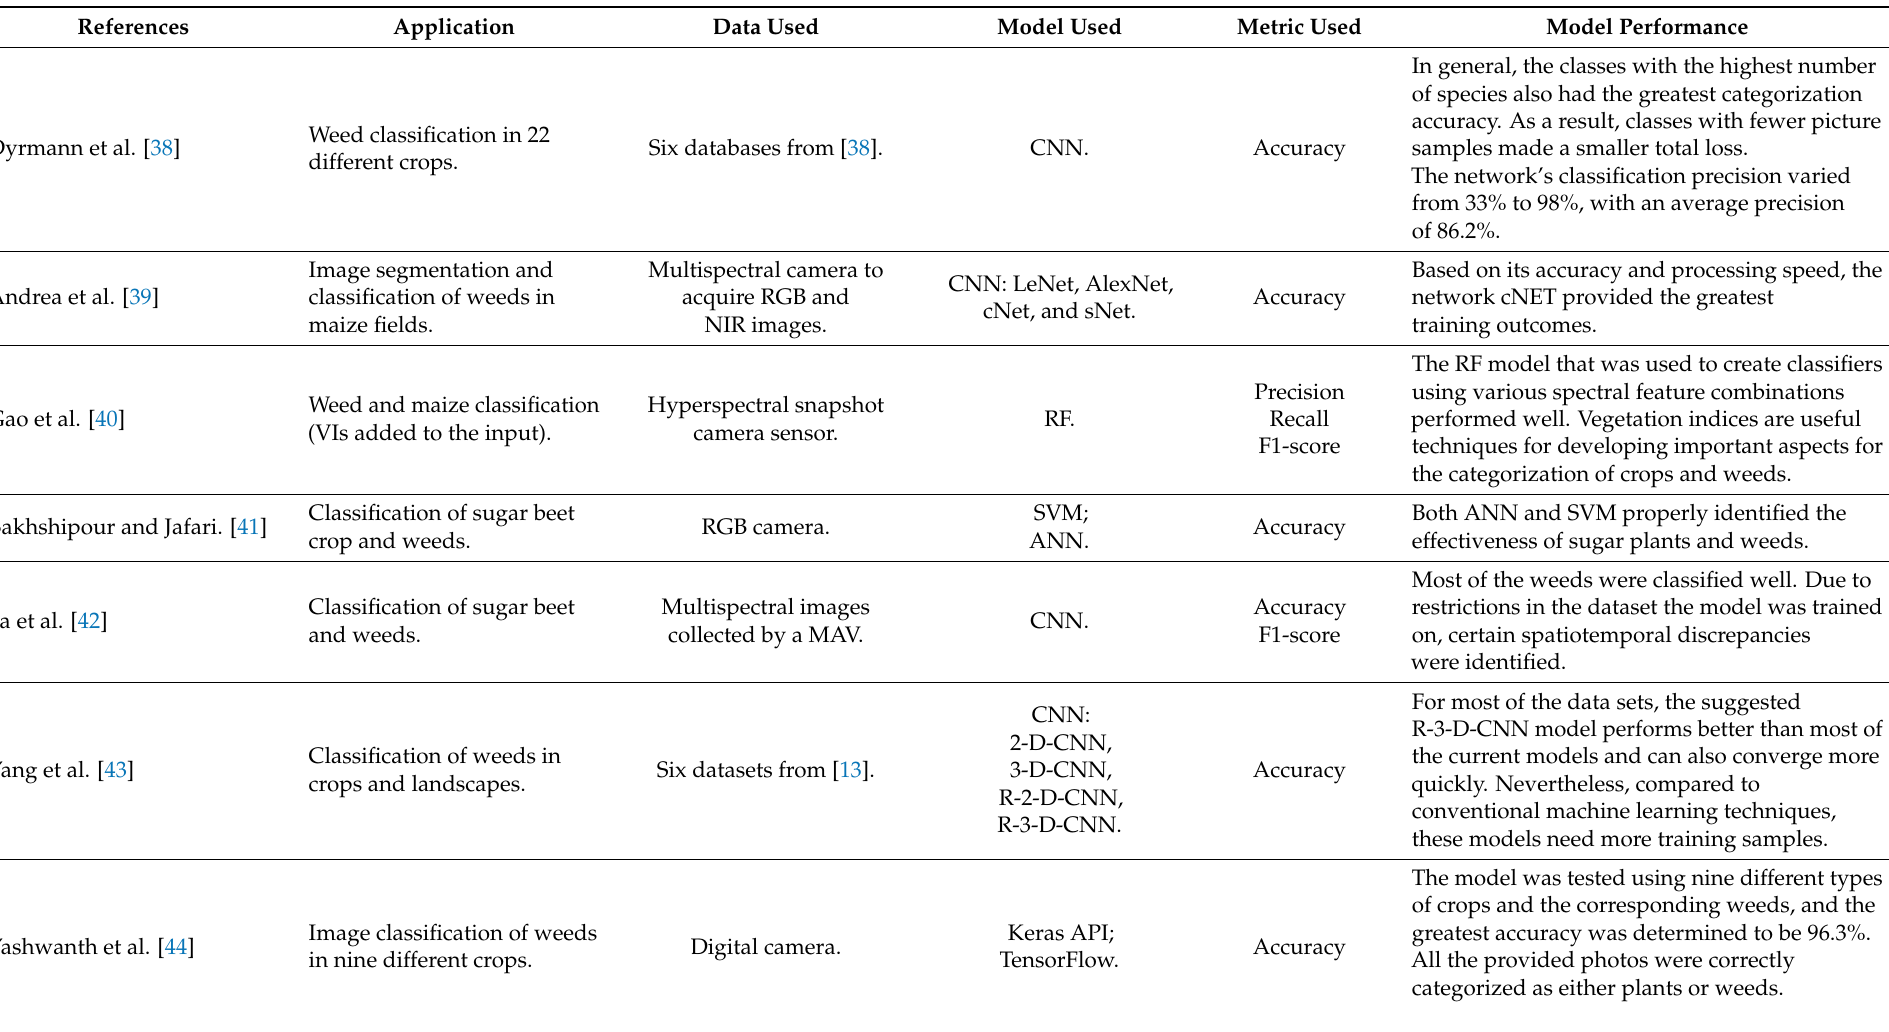
Table 5. Feature descriptions of publications in the field of “Weed